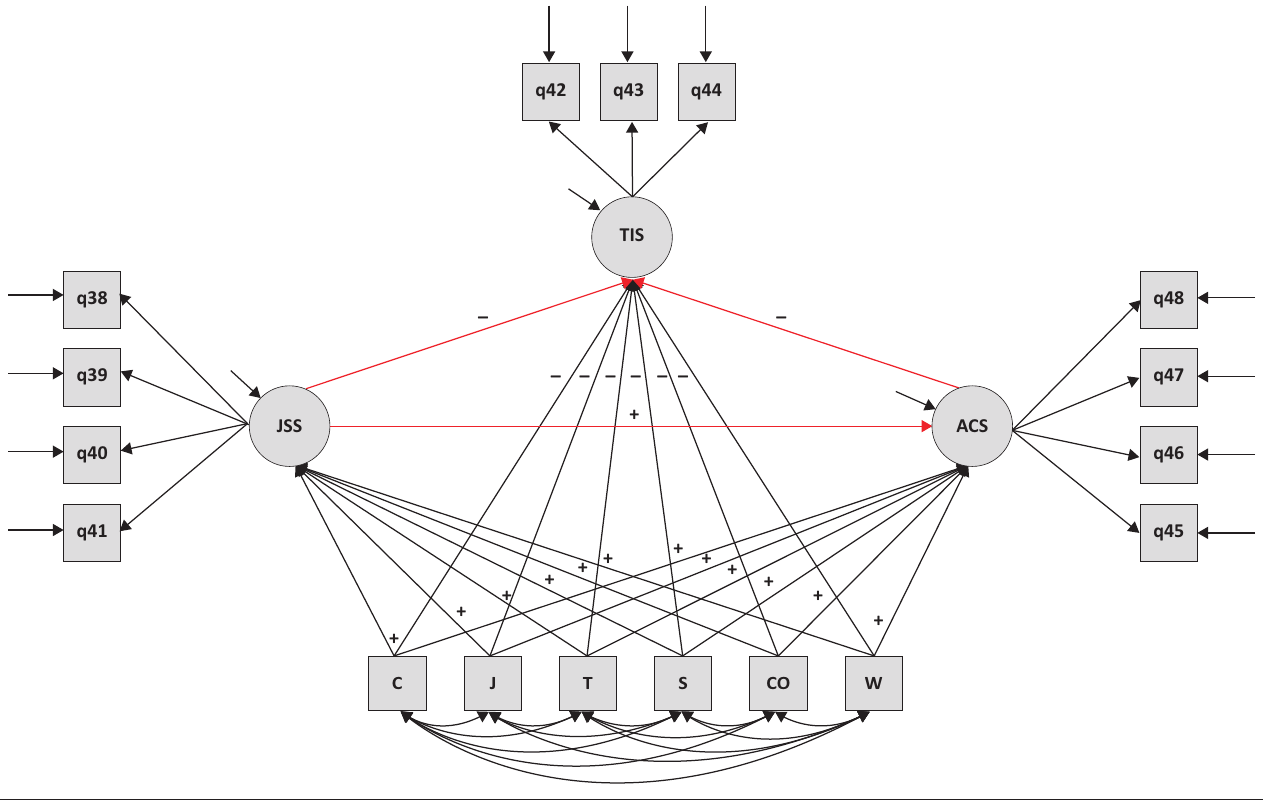
FIGURE 2: The structural equation path model (EwC-on-Crt 1&2 ) of the relationship between the variables of the Retention Factor Scale and the attitudinal antecedents of voluntary turnover scales.